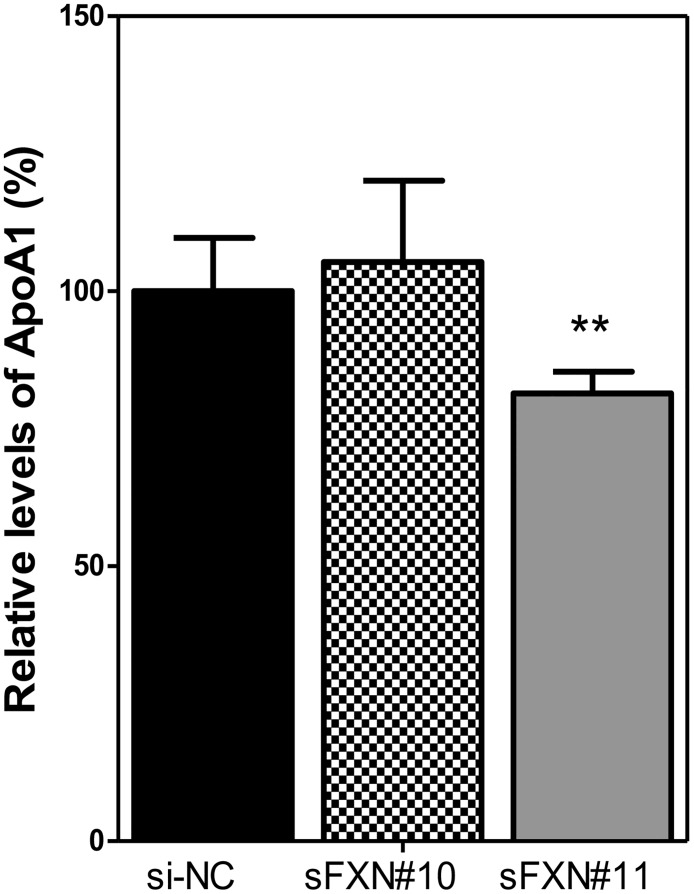
ApoA1 secreted by frataxin knockdown HepG2 cells.Levels (means ± SD; n = 3) were normalized to cellular protein concentration. **P < 0.01.